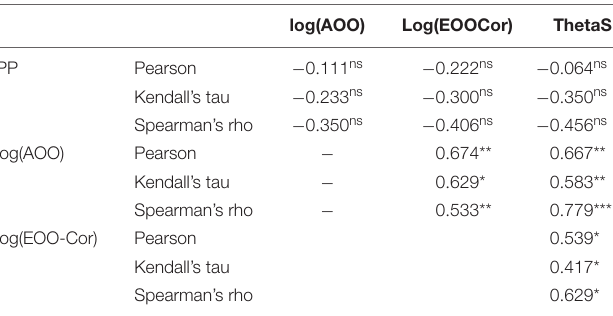
TABLE 3 | Pairwise correlations between the area of occupancy (AOO), the extent of occurrence (EOOCor), the posterior probabilities (PP) and ThetaS as an estimation of θ for the Groups of Table 2